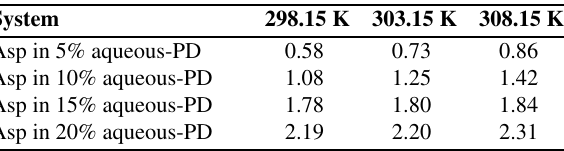
of Asp in aqueous and aqueous-PD (5, 10,15 and ,s,